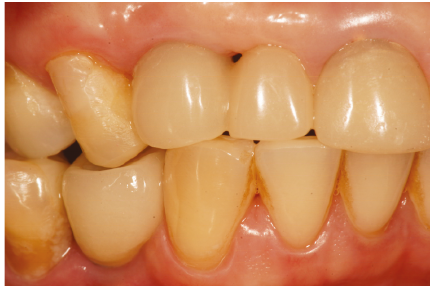
Figure 9: Gradual closing of the black triangle.